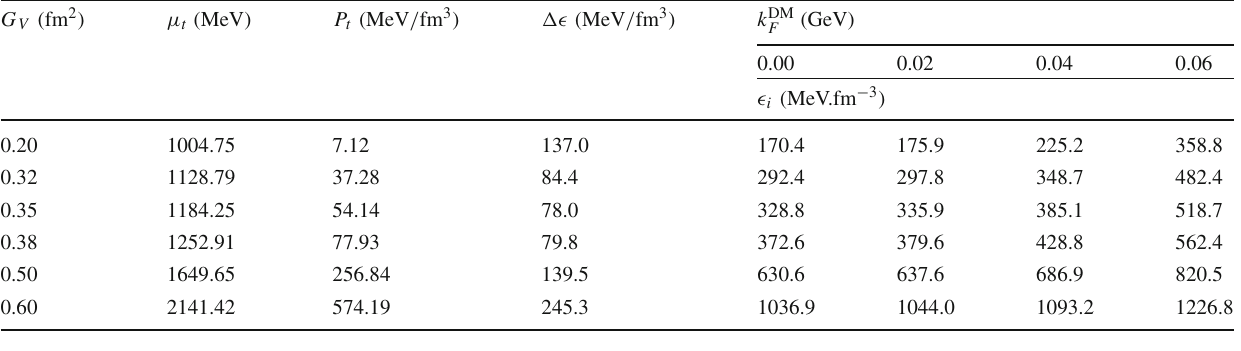
Fig. 2 Mass as a function of the radii for the hybrid EoSs for different values of k DM and G V . F Full and dashed lines indicate the hadronic and hybrid sectors in the sequences, respectively. In all diagrams are shown constraints from the ∼ 2 M